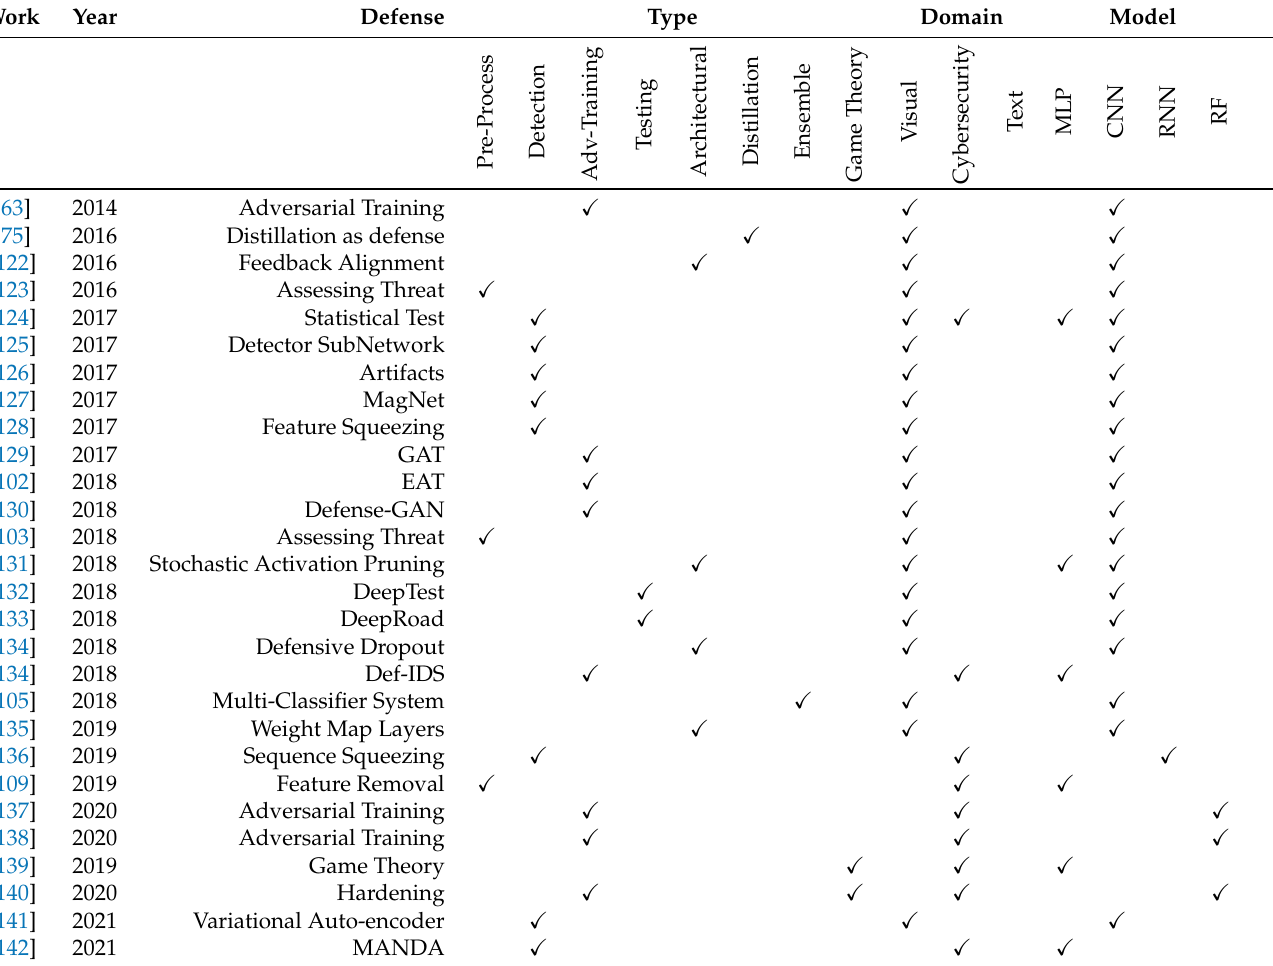
Figure 6. Common defence types against adversarial machine learning. Table 8. Chronologically ordered summary of defenses against adversarial